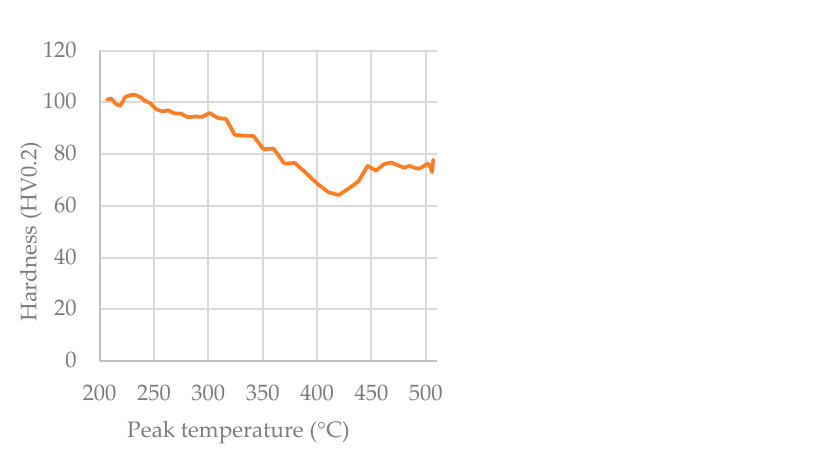
Figure 21. Hardness trend as a function of peak temperature relating to T510V5 test (T4 state). Curves like those proposed in Figure 21 were obtained by varying the treatment speed and the peak temperature. Overall, these trends showed great repeatability and those proposed in Figure 22 are sufficiently representative of the softening achieved in the alloy in the T4 state for both investigated treatment speeds. There is an overlap of the hardness values obtained with thermal cycles at different peak temperatures when setting the treatment speed. Hence, a single Gleeble test at a peak temperature of 510 °C allows for the hardness values of all peak temperatures of interest to be explored. In the T4 state, the maximum softening treatment temperature is between 420 and 430 °C and an increase in the laser treatment speed involves a reduction in maximum achievable softening. ( a ) ( b ) Figure 22. ( a ) Hardness trend as a function of peak temperature related to laser treatments with a speed of 5 mm/s (T4 state); ( b ) Hardness trend as a function of peak temperature related to laser treatments with a speed of 7.5 mm/s (T4 state). With the aim of modelling the effect of peak temperature and treatment speed on the micro-hardness obtained in APS and T4 states, micro-hardness trends, as a function of peak temperature obtained in different repetitions, were interpolated with polynomials. Figure 23 summarizes the obtained results. Figure 23a shows interpolation curves relating to T4 state with a continuous line, while some of the hardness measurements obtained at treatment speeds of 5 mm/s and 7.5 mm/s are indicated by empty circles and squares, respectively. The same procedure was adopted for the results in the APS state. Consider- ing only the interpolation curves, Figure 23b shows a comparison between T4 state and APS state and the two treatment speeds; all polynomials fit the experimental data with